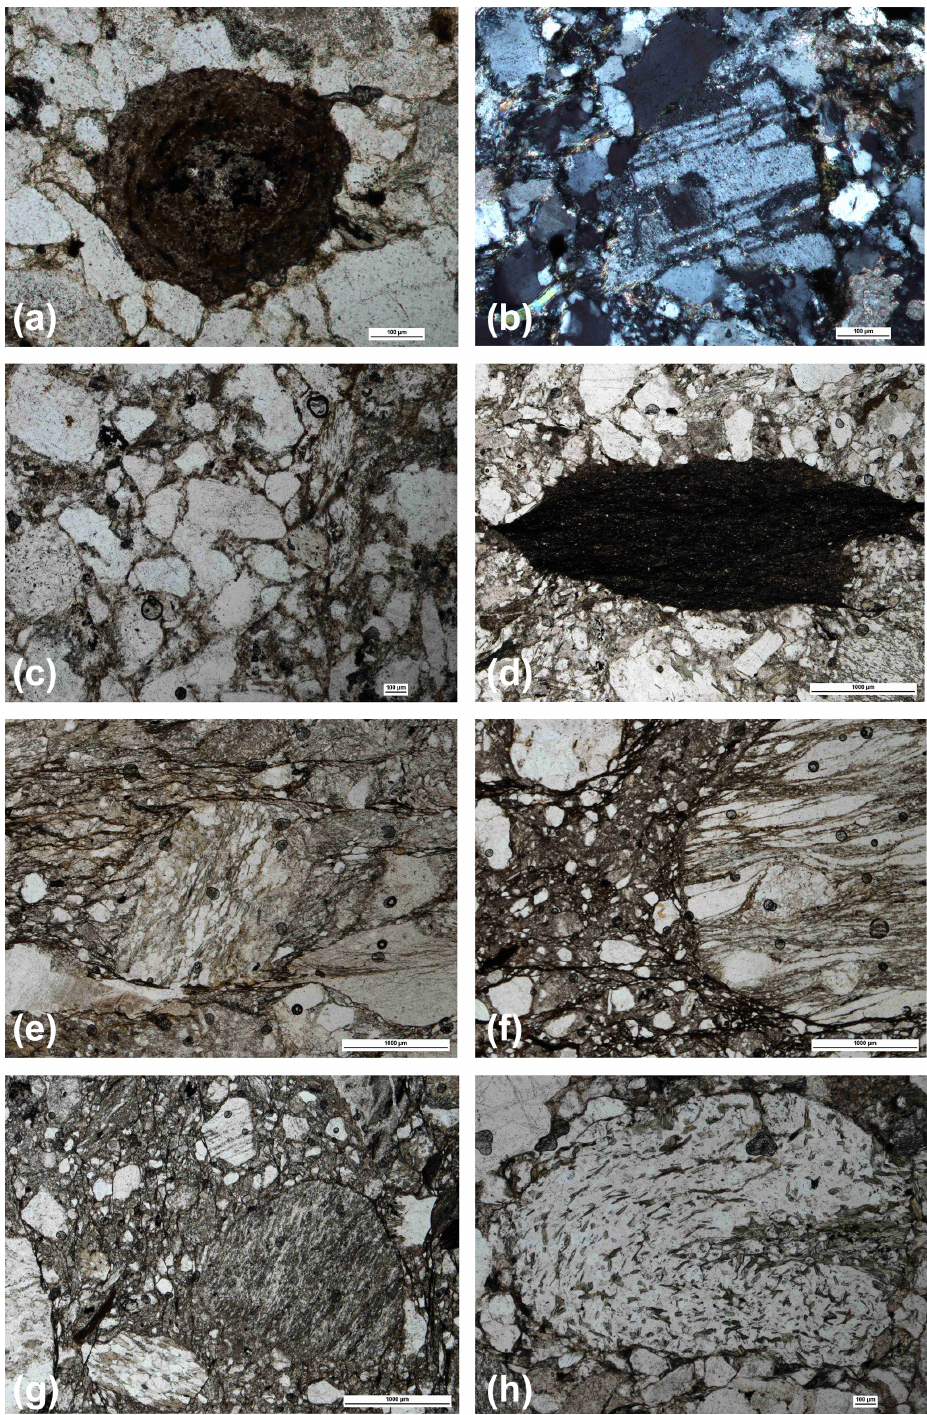
Figure 7. Microphotographs of the sedimentary textures in the LPa formations, surrounding clasts of different natures. (a) Bioclast in a Rábano Formation quartzlitharenite; (b) plagioclase mineraloclast in a Rábano Formation quartzlitharenite; (c) broken up volcanic quartz crystals in a Rábano Formation quartzlitharenite; (d) lithoclast made of black phyllite in a San Vitero Formation litharenite; (e) rounded clast displaying tectonic foliation almost normal to the surrounding external C 1 foliation (San Vitero Formation); (f) partial view of a rounded clast displaying mylonitic banding in an Almendra Formation microconglomerate; (g) randomly oriented clasts bearing previous foliation in an Almendra Formation microconglomerate; (h) rounded foliated clast displaying a microfold in an Almendra Formation microconglomerate.